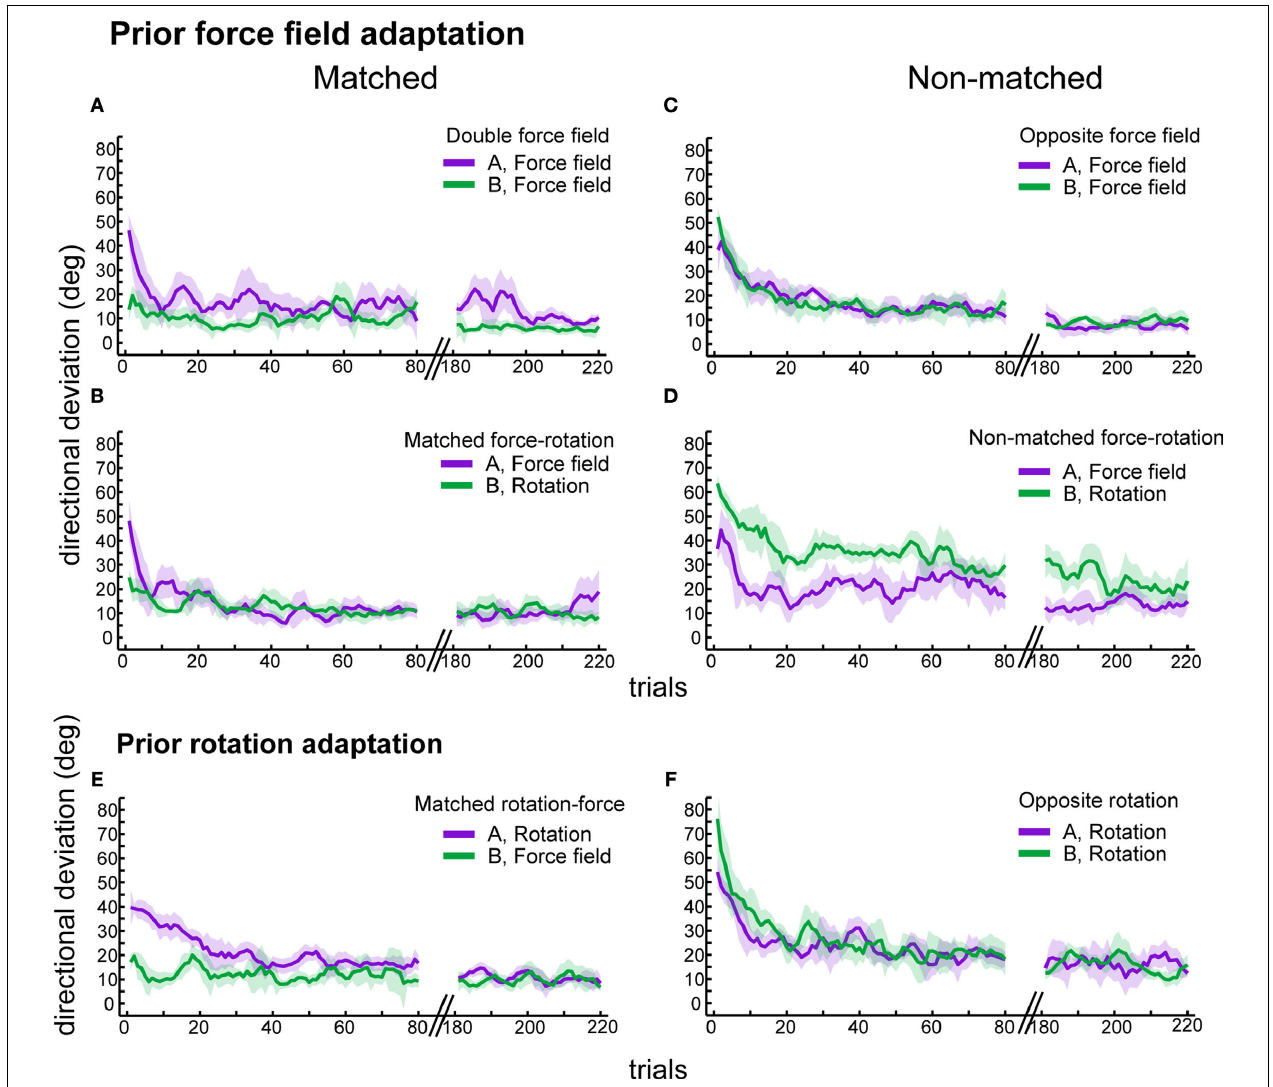
matched force-rotation (D) , matched rotation-force (E) , and opposite rotation (F) . Plots are organized according to the direction of the perturbations, i.e. matched (left) and non-matched (right). Only the fi rst 80 trials and last 40 trials are